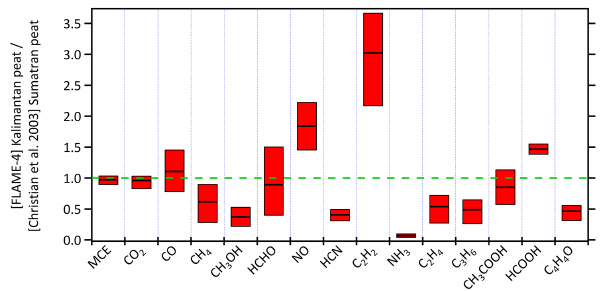
Figure 6. The ratio of our Kalimantan peat fire EFs to the EFs from the single Sumatran peat fire of Christian et al. (2003). The upper and lower bounds of the bars represent ratios based on the range of our data, while the lines inside the bars represent the FLAME-4 study-average